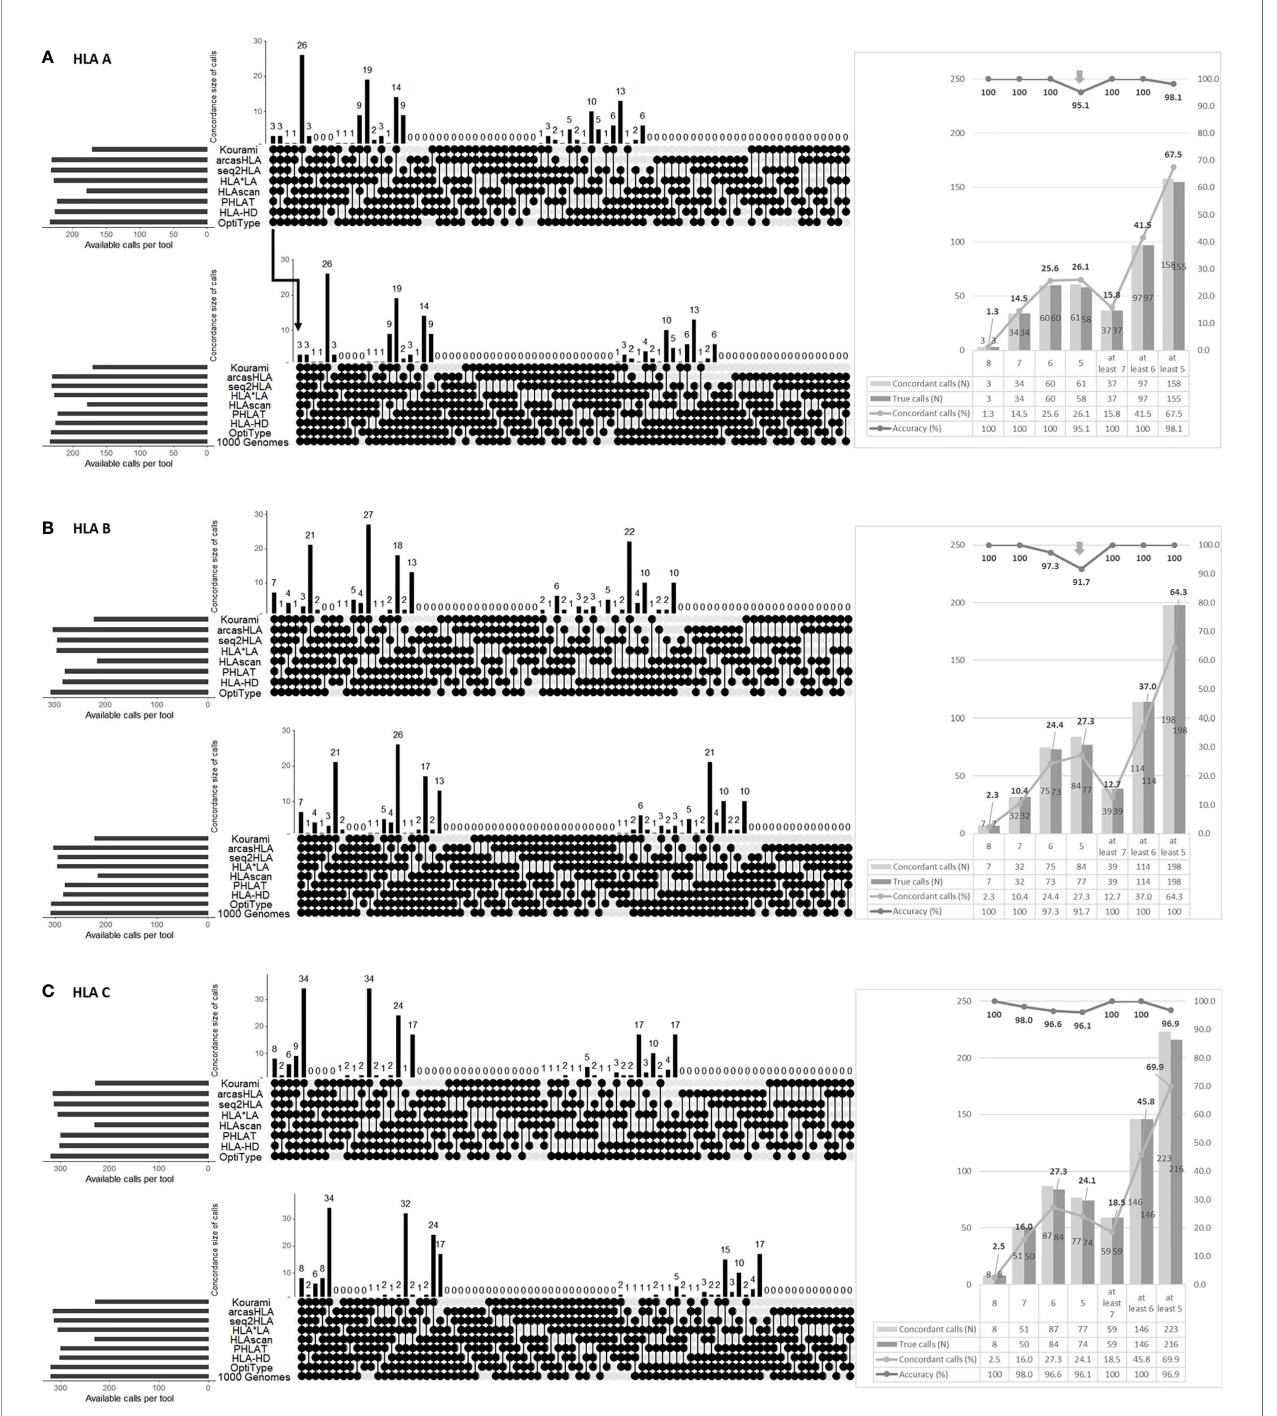
FIGURE 2 | Performance analysis of HLA genotyping by combining the eight tools in HLA-A (A) , HLA-B (B) , HLA-C (C) . The upper part in each (A – C) shows the combinations of tools presenting the concordant calls. The round dots indicate the tools included in the combination. The number is the cases of each combination. The lower part in each (A – C) shows the accuracy of each combination. Each combination ’ s number in the lower part means that the concordant calls matched with the 1000 Genome Project data (i.e., “ 1000 Genome ” points are additionally included in the combination). Therefore, the accuracy is the number of lower parts (the number of concordant calls matched with 1000 Genome Project data) divided by the number of upper parts (the number of concordant calls). The right part of each of (A – C) shows the number and percentage of concordant calls according to the number of matched calls regardless of the tool type and the number of true calls among these concordant calls and their